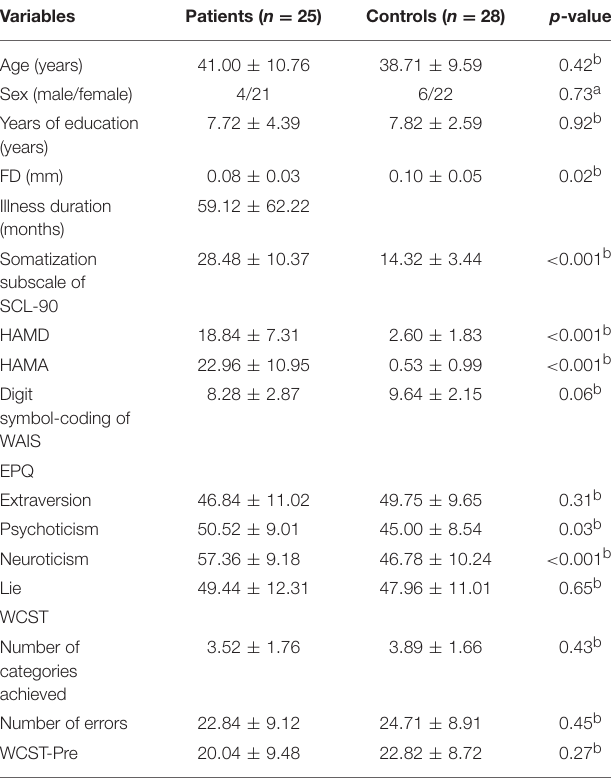
TABLE 1 | Characteristics of the